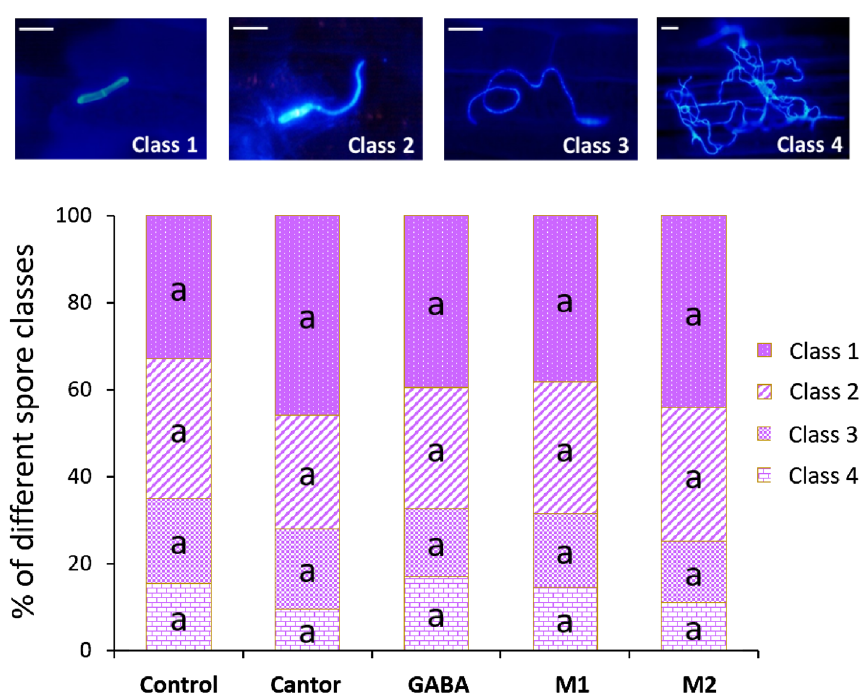
Figure 4. In planta effect of γ- aminobutyric acid (GABA), M1, M2 and Cantor treatments on the epiphytic hyphal growth of Zymoseptoria tritici (strain T02596) on the wheat leaves (cultivar Alixan), compared to the water-treated control. Three third-leaf segments with 100 fungal spores monitored on each were used as replicates in each condition. Four different classes of Calcofluor-stained germinated spores were assessed five days post-inoculation (class 1, non-geminated spores; Class 2, geminated spores with small germ tube; class 3, geminated spores with developed germ tube; class 4, geminated spores with a strongly developed germ tube). Within each class, bars with common letters are not significantly different using the Tukey test at P = 0.05. Scale bar = 10